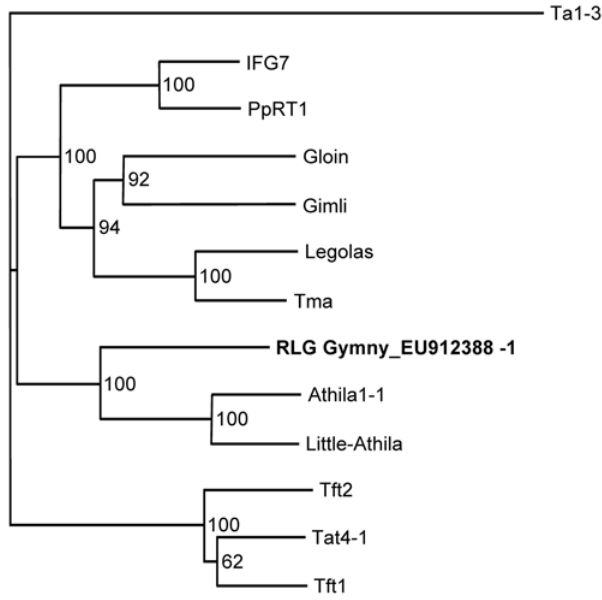
Figure 2. RLG_ Gymny _EU912388-1 is related to Arabidopsis Athila -like retrotransposons. Relatedness tree generated from alignment of RT sequences in Figure S1 and the RT domain from the Arabidopsis Ta1-3 Copia -like retrotransposon (Accession number